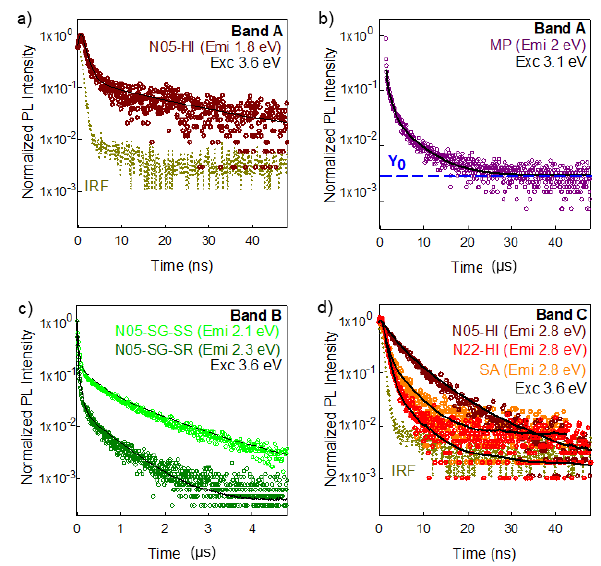
Figure 6. Time dynamics of excitonic and defect emissions in different ZnO materials: ( a ) PL time decays of one bare ZnO NPs (N05-HI) at 1.8 eV (corresponding to band A) under pulsed excitation at 3.6 eV; ( b ) PL time decays of micrometric powder (MP) at 2 eV (corresponding to band A) under pulsed excitation at 3.1 eV ( c ) PL time decays of ZnO NPs grown on silica substrates (N05-SG-SS, N05-SG-SR) at 2.1 eV and 2.3 eV, respectively (corresponding to band B), under pulsed excitation at 3.6 eV; ( d ) PL time decays of the bare ZnO NPs (N05-HI, N22-HI), and their capping agent (stearic acid, SA) at 2.8 eV (corresponding to band C) under pulsed excitation at 3.6 eV. In panels ( a , d ), the instrument response functions (IRF) are also shown (mustard dotted line). From ( a – d ), the signal decays are fitted as multiexponential functions (black solid lines). In ( b ) a constant parameter (y0) as backgrounds was also used. The sets of all parameters used to model the PL decay are reported in Table S5.